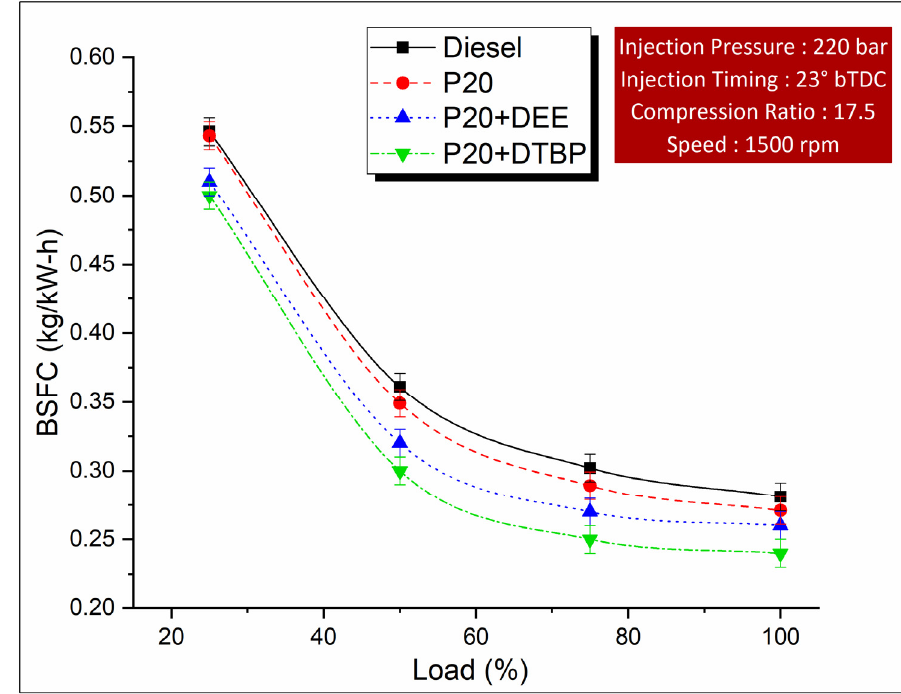
Figure 5. BSFC variation for test fuel blends at different load condition.